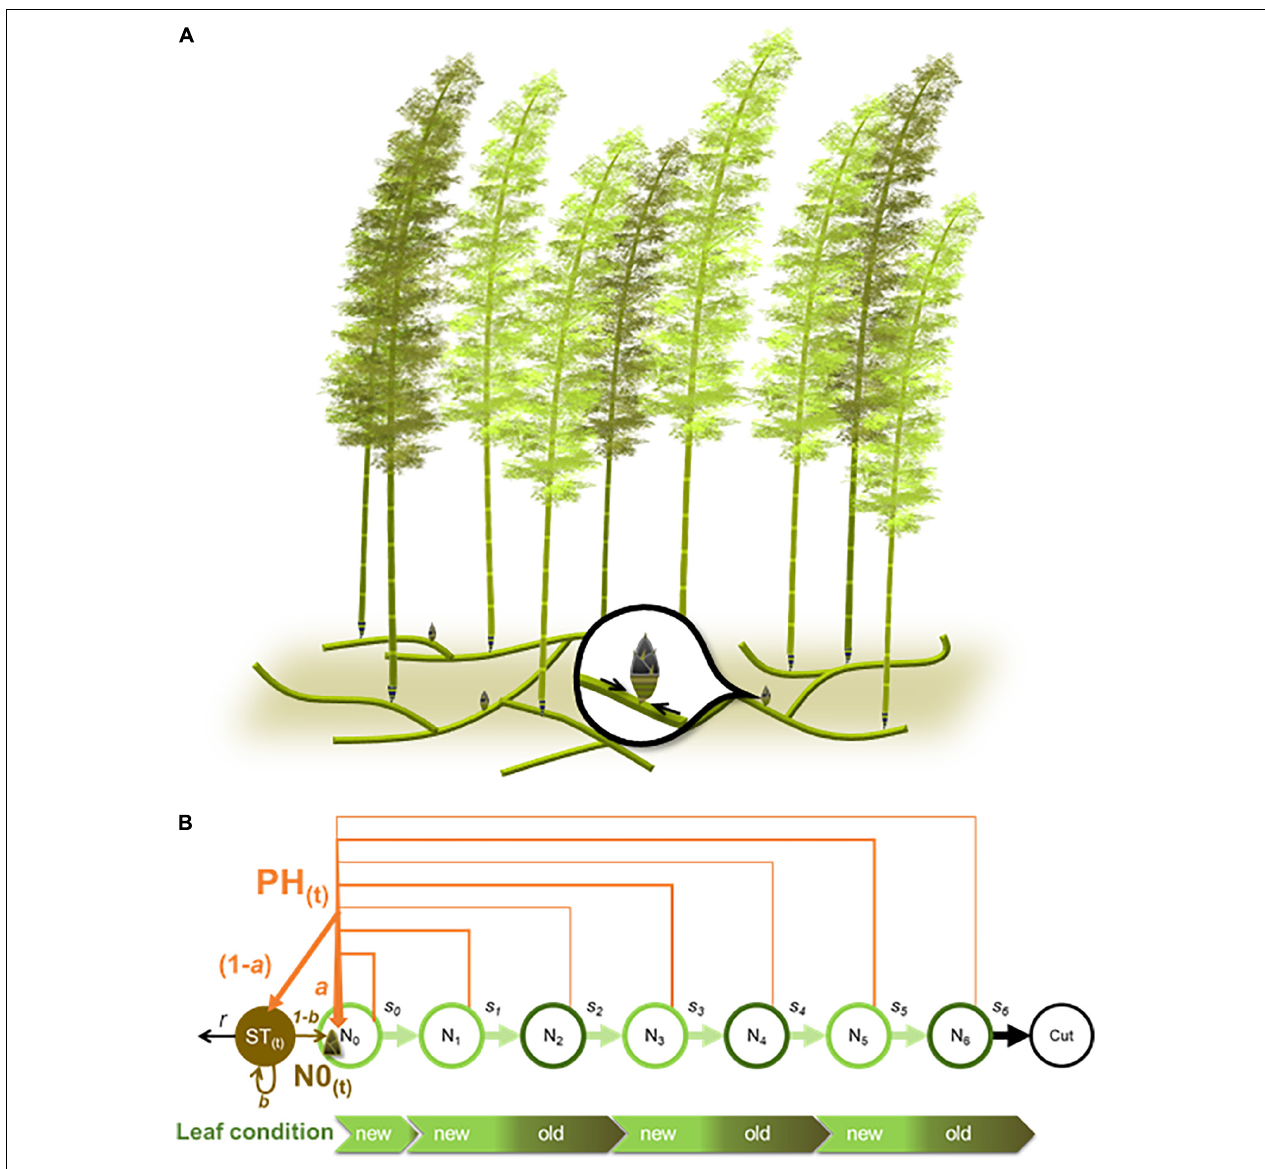
FIGURE 1 | Schematic representation of (A) a Moso bamboo forest showing clonal new shoot reproduction with a rhizome system and (B) the Moso bamboo age-structured model. In (A) , black arrows represent flows of carbohydrates from surrounding adult culms to a new shoot via rhizomes. In (B) , N i represents the density of bamboo culms of age i . PH( t ) and ST( t ) represent net annual carbohydrate in leaves and belowground carbon storage at year ( t ), which is determined by proportions a and b and carbon loss fraction r . The orange and brown arrows represent flows of carbohydrates; the brighter and darker green horizontal arrows represent transitions to the next culm age classes with the survival rate s i of 0.95 and 0, respectively. Leaf conditions in culm age classes are also shown using green color bars; length of the bars represent leaf life span, and brighter and darker green colors correspond to newer (first year) and older (second year) leaves,